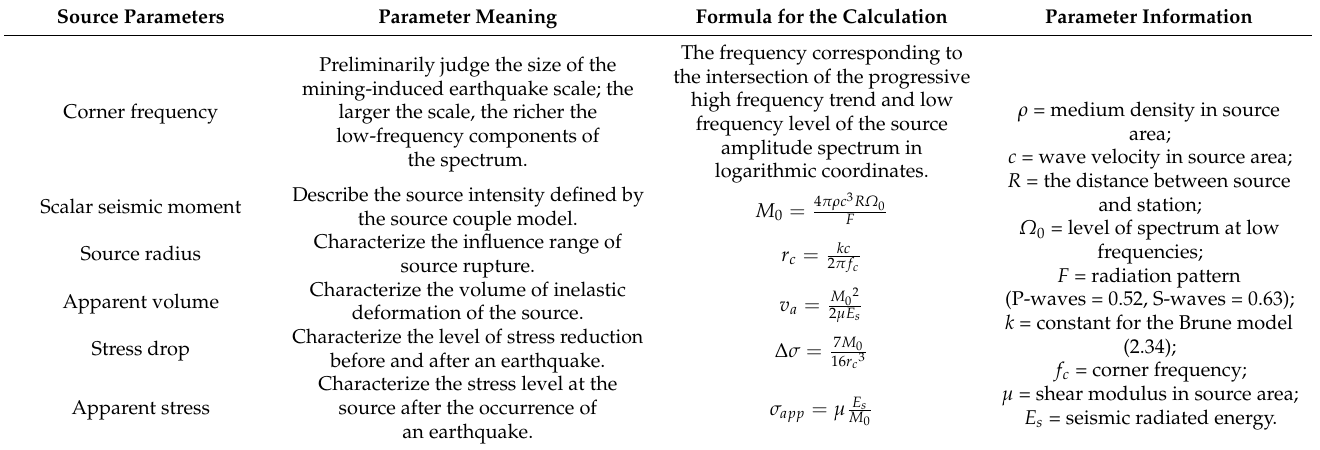
Table A1. Common source parameters and physical